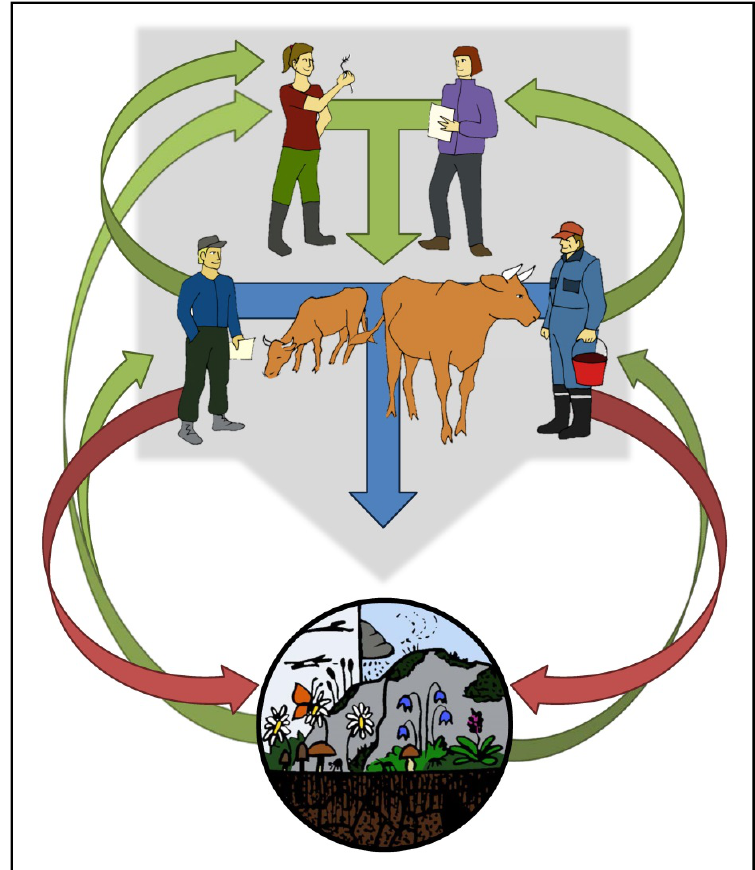
Figure 4:Site-specific collaborative management planning brought together biologists of regional authorities and non-governmental management advisors (project workers; top row) with landowners and cattle owners (local actors; middle row). The general aim of the management plan was to enhance the biodiversity, landscape value, and provision of ecosystem services related to the site (bottom circle) by introducing grazing. Green arrows represent the flows of information during the planning process. Knowledge was gathered on current biophysical attributes and land-use history of the site. These were coupled with the scientific knowledge of the project’s workers and fitted to the economic framework of the manager’s business (a cattle farmer or a civic association). In order to organize management and apply for funding, further cooperation between the landowner(s) and the manager was encouraged (networking; blue arrow). The viewpoints and interests of local actors (red arrows) were explored and integrated within the management